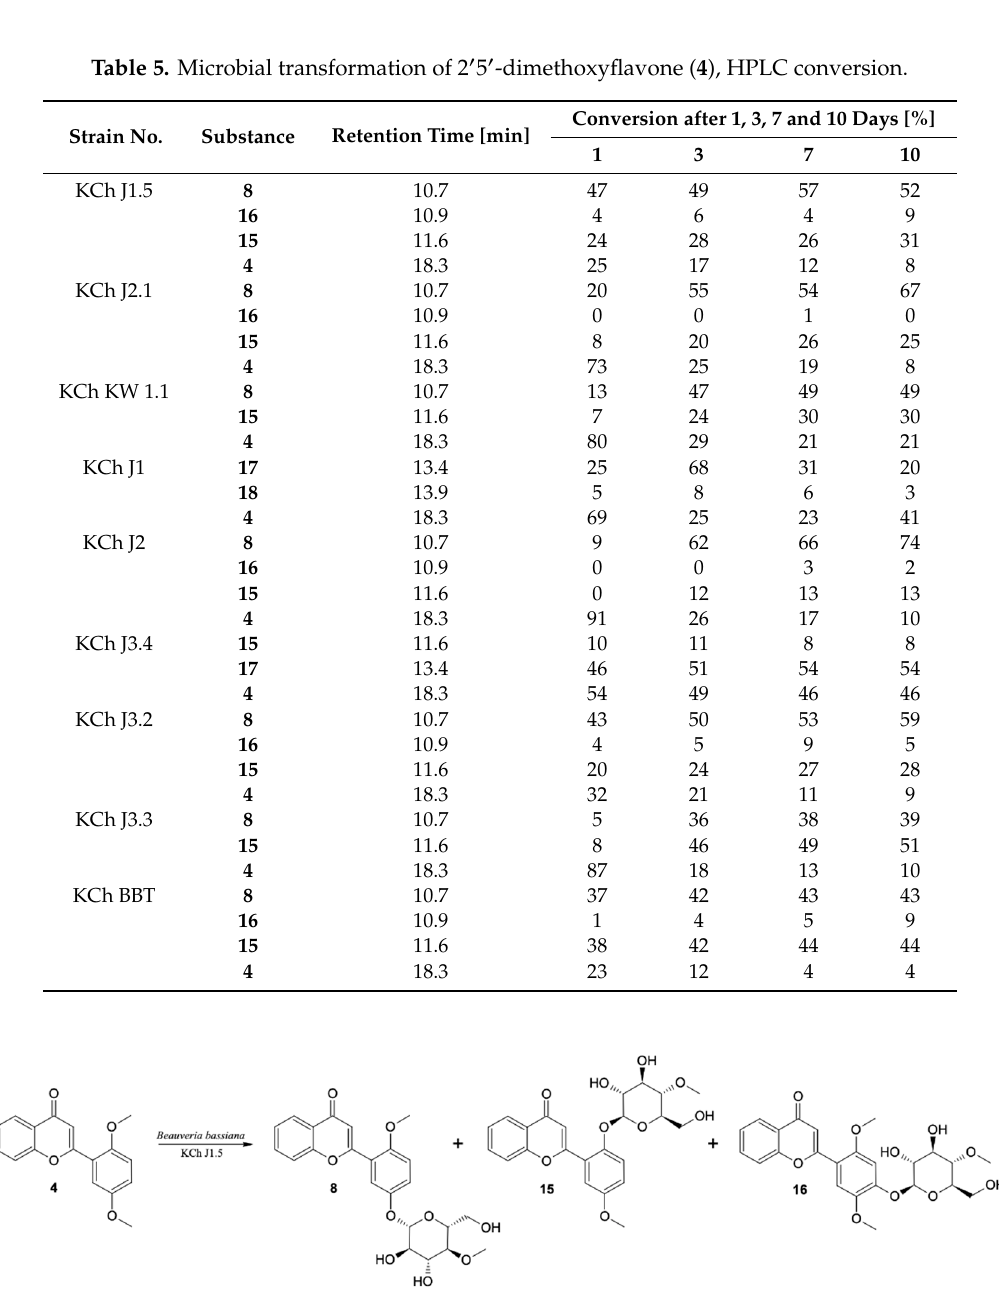
Figure 7. Biotransformation of 2 ′ 5 ′ -dimethoxyflavone ( 4 ) by I. farinosa KCh KW1.1 and B. bassiana KCh J1.5